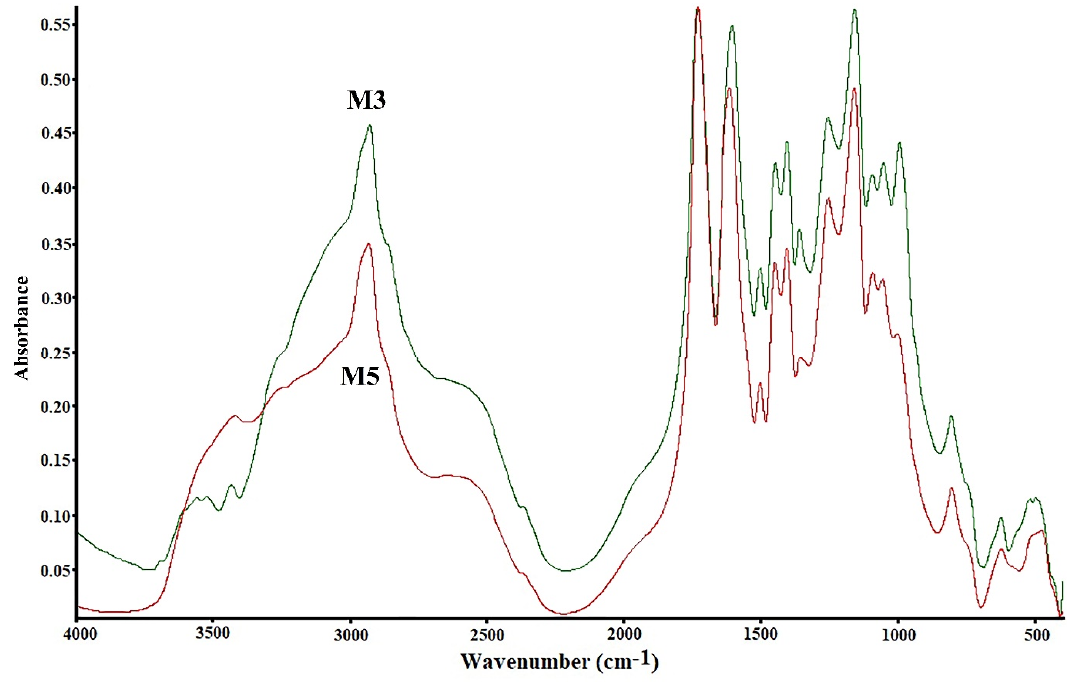
Figure 1. FTIR signals of hydrogels poly(DMA ‐ co ‐ AAc).